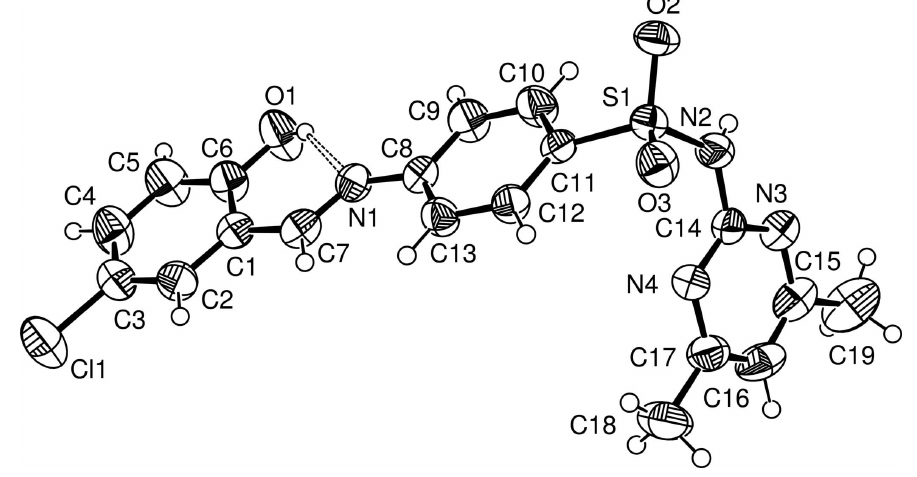
H Cl N O S, with the atom numbering 19 17 1 4 3